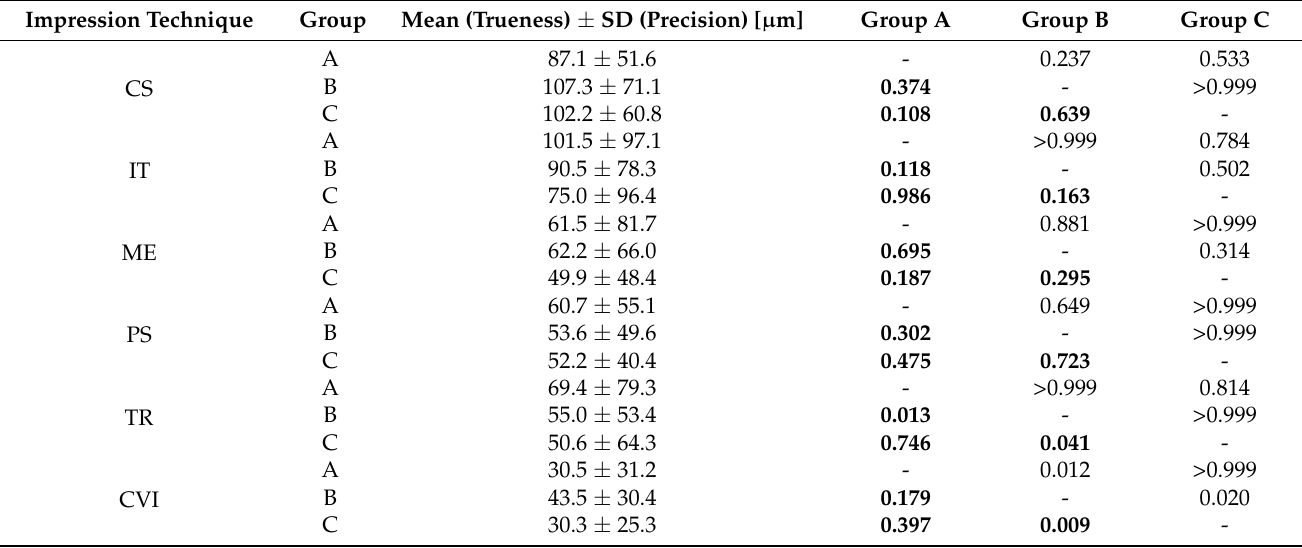
Figure 4. Boxplot diagram of pooled data of the deviations of linear distances for the six impression techniques (CS = CS 3800, IT = iTero Element 5D, ME = Medit i700, PS = Primescan, TR = Trios 4, CVI = conventional impression) classified to group A, B, and C; outliners (O), extreme values (*). Table 2. Deviations (mean ± standard deviation (SD) [ µ m]) of the pooled data of linear distances (D1_2, D1_3, D1_4, D2_3, D2_4, D3_4) of six impression techniques (CS = CS 3800, IT = iTero Element 5D, ME = Medit i700, PS = Primescan, TR = Trios 4, CVI = conventional impression) for all groups and statistical analysis for trueness (upper right part) and precision (lower left part, presented in bold type) according to ISO 5725 [6] .